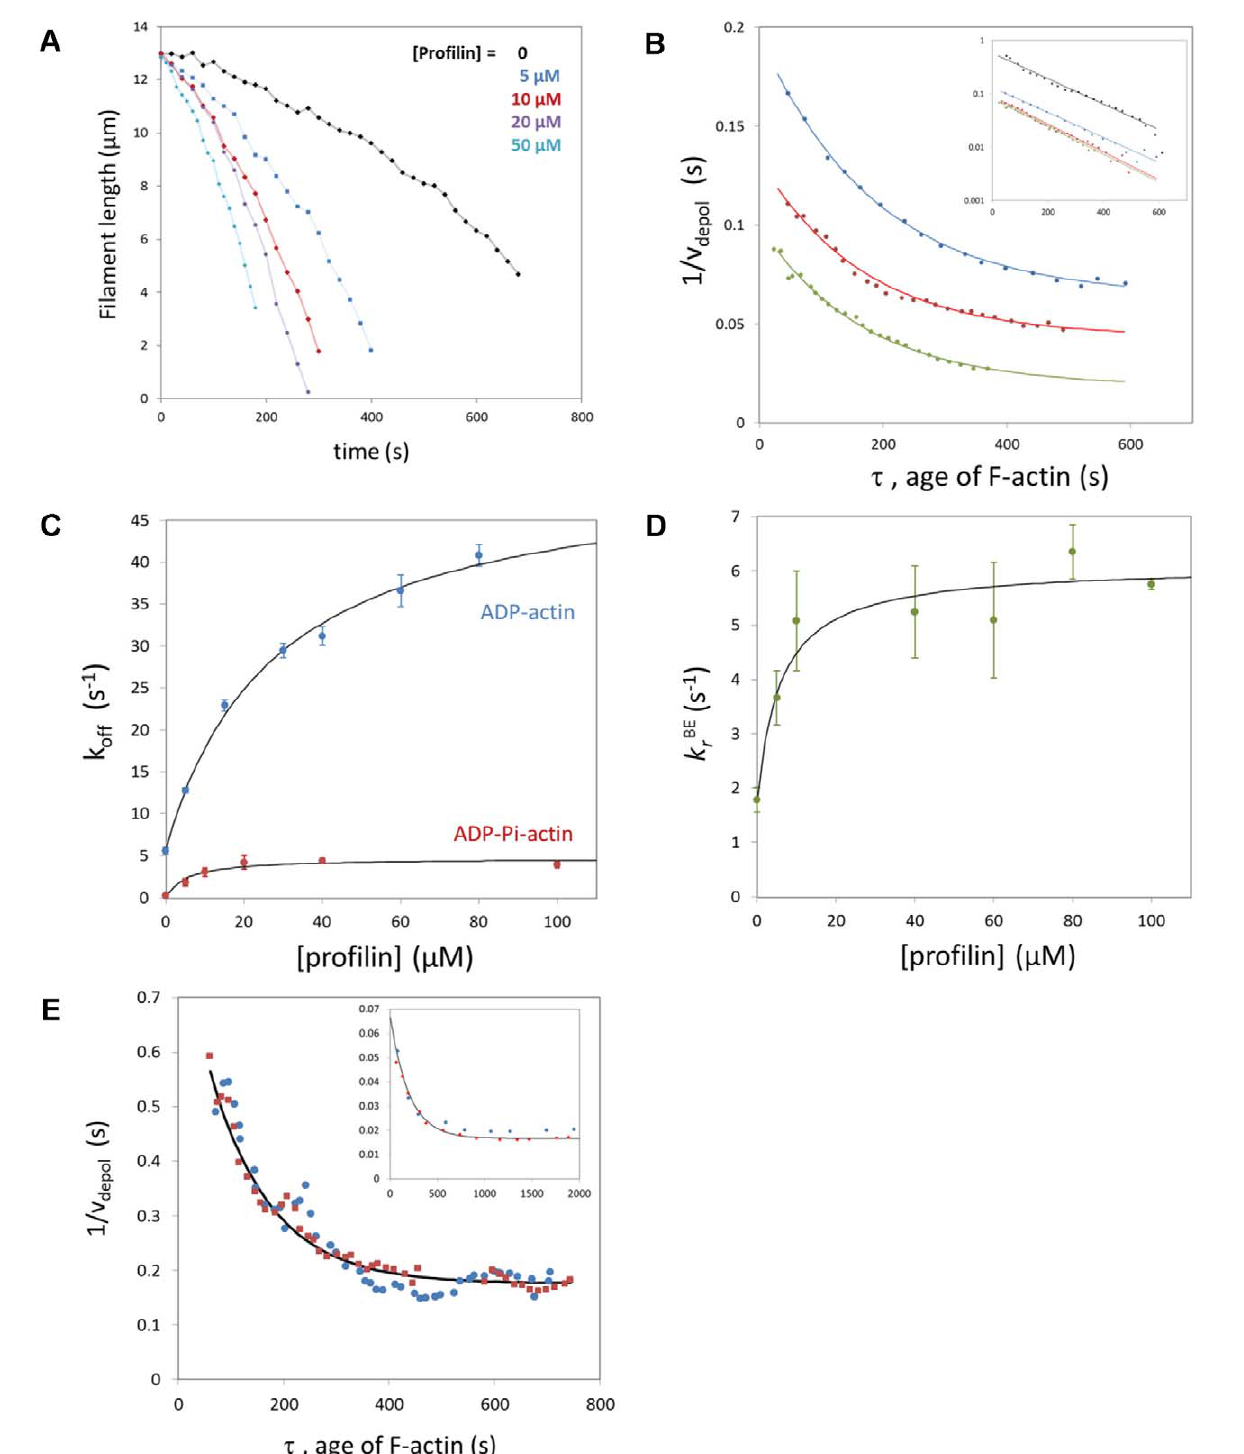
Figure 4. Effect of profilin on actin dynamics and phosphate release at the barbed end. (A)Time course of filaments depolymerizing in the presence of 0 (black), 5 m M (blue), 10 m M (red), 20 m M (purple), or 50 m M (cyan) profilin, after elongation with 1.5 m M actin for 5 min. (B) 1/ v depol versus the age of F-actin measured on filaments depolymerizing with 5 m M (blue), 10 m M (red), and 80 m M (green) profilin, and exponential fits (lines). ! 1 { 1 for the same data, compared to a filament depolymerizing without profilin (black). (C) Effect of profilin on Inset: log-linear plots of v depol v ADP depol the off-rates of ADP-actin and ADP-Pi-actin (measured on CrATP-actin). The lines are saturation curves fitting the data, assuming that profilin is in rapid equilibrium with the barbed end of the filaments. (D) Effect of profilin on the Pi release rate constant at the barbed end, k BE on the molecular scheme shown in Figure 3, and fitted by a saturation curve assuming that profilin is in rapid equilibrium with the barbed end. (E) Pi decay profiles (1/ v depol versus the age of F-actin) measured on filaments elongated with 2 m M actin and 6 m M (blue) or no (red) profilin, and PLoS Biology |